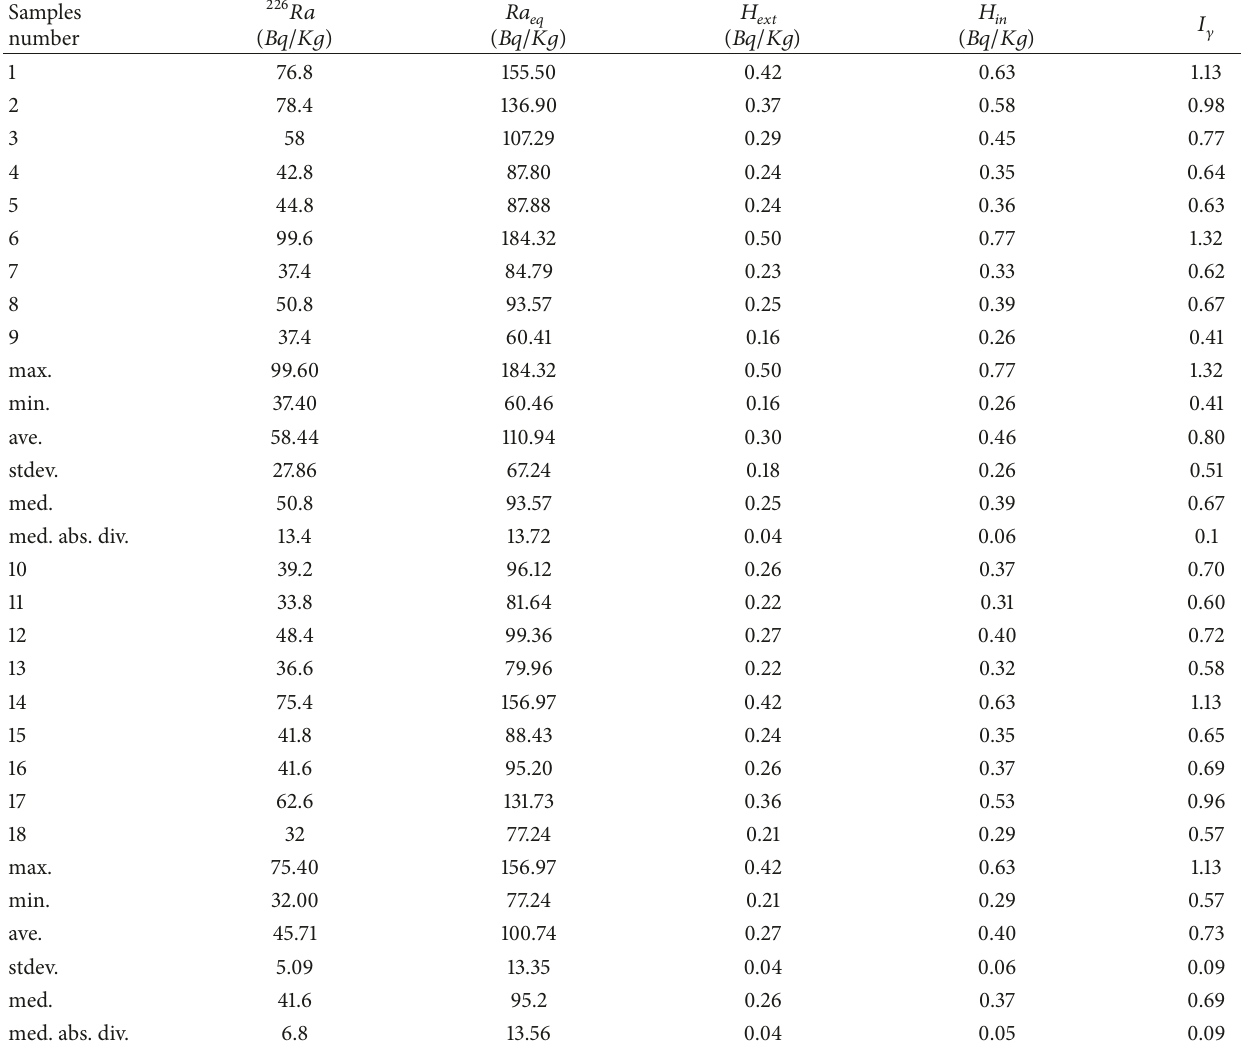
Table 7: The measured values for 𝑅𝑎 𝑒𝑞 [7], H ext , H in hazard indices in (𝐵𝑞/𝐾𝑔) and the radioactivity level index 𝐼 𝛾 for 18 clay soil samples, in addition to its max., min., ave., stdev., med., and med. abs. div. values.